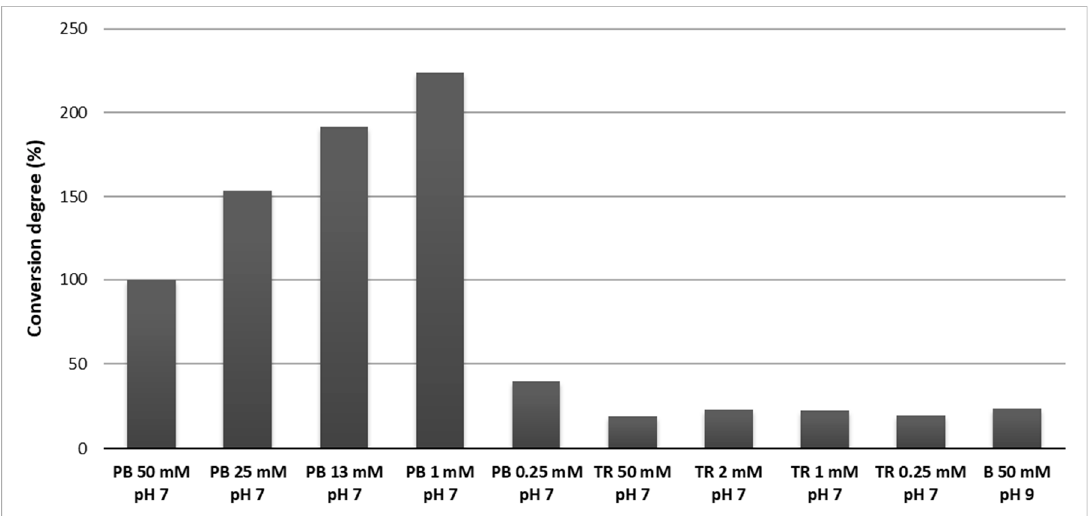
Figure 5. Substrate (GTX5) conversion degree by carbamoylase in buffers with different and pH. PB—phosphate bu ff er, TR—Tris bu ff er, B—borate bu ff er. Conversion degree values were composition and pH. PB—phosphate buffer, TR—Tris buffer, B—borate buffer. Conversion degree normalized w.r.t. 50 mmolL − 1 phosphate bu ff values were normalized w.r.t. 50 mmolL − 1 phosphate buffer.